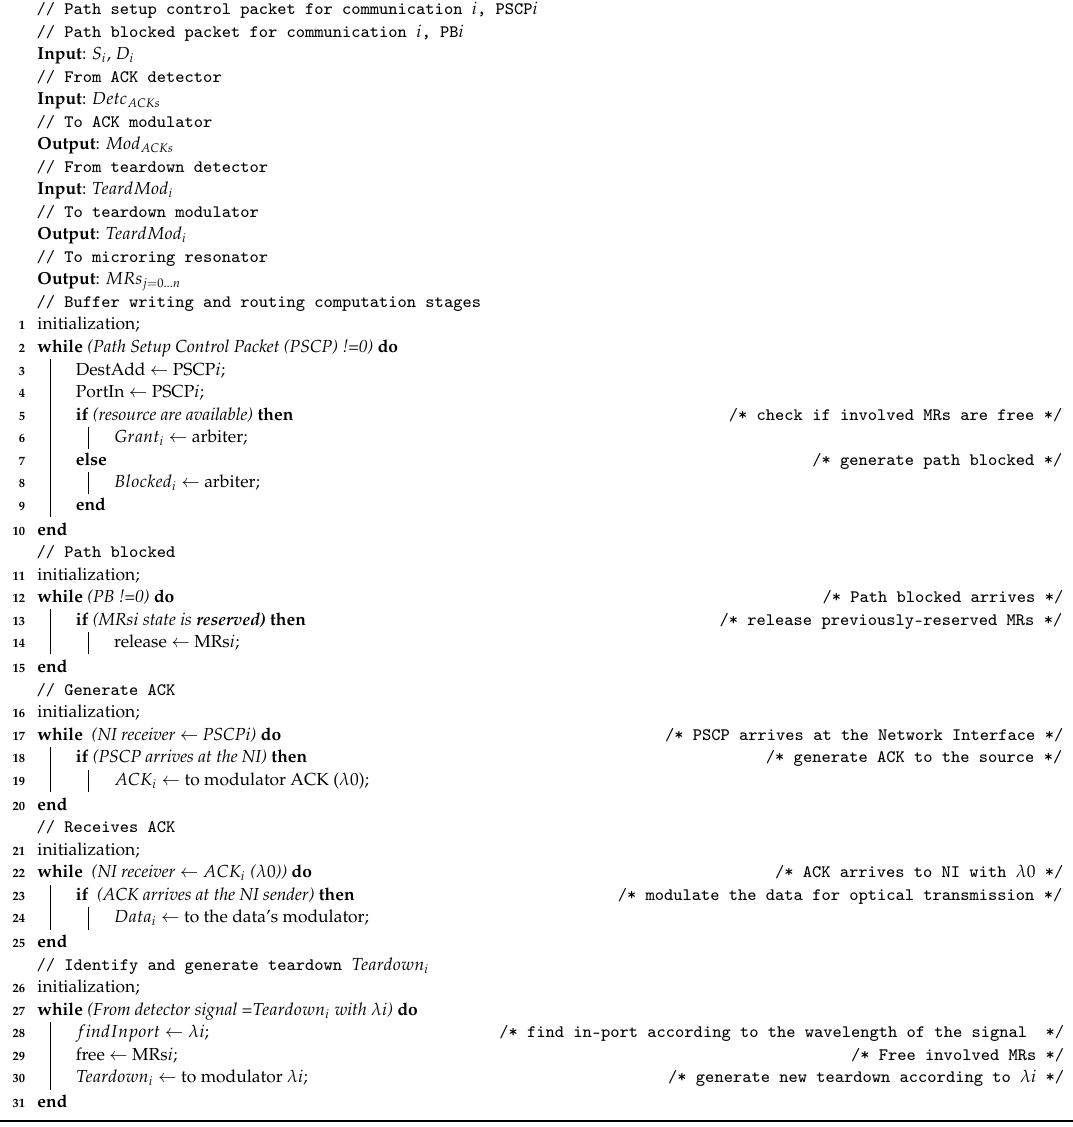
Algorithm 1: Contention-aware path configuration